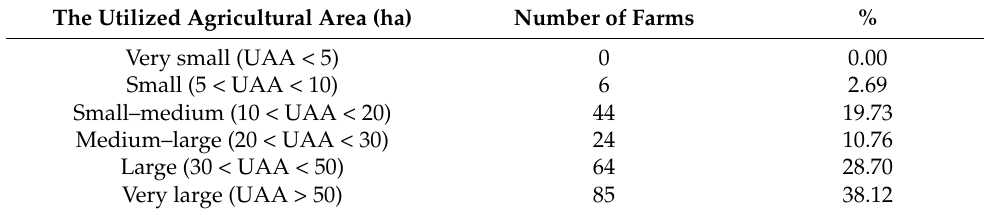
Table 1. Structure of farms by utilized agricultural area.